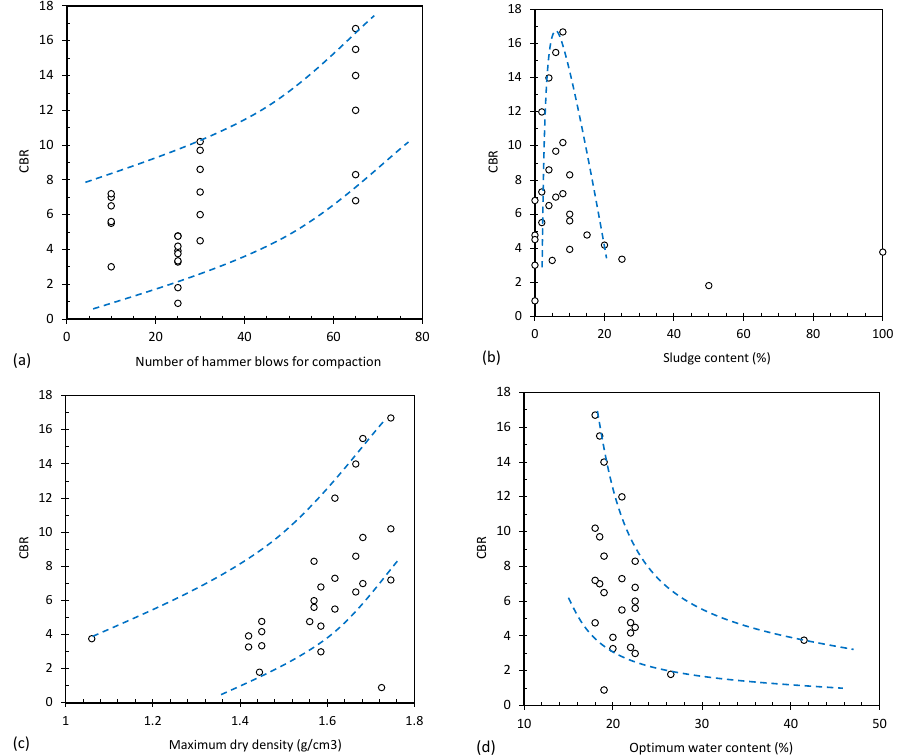
Figure 5. Effect of ( a ) number of compaction blows, ( b ) sludge content, ( c ) MDD, and ( d ) OMC on the CBR in the collected database.